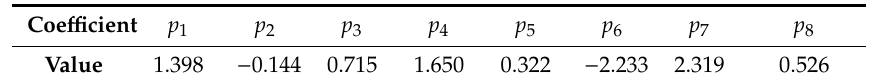
Table 2. Coe ffi cients in Equation (4).